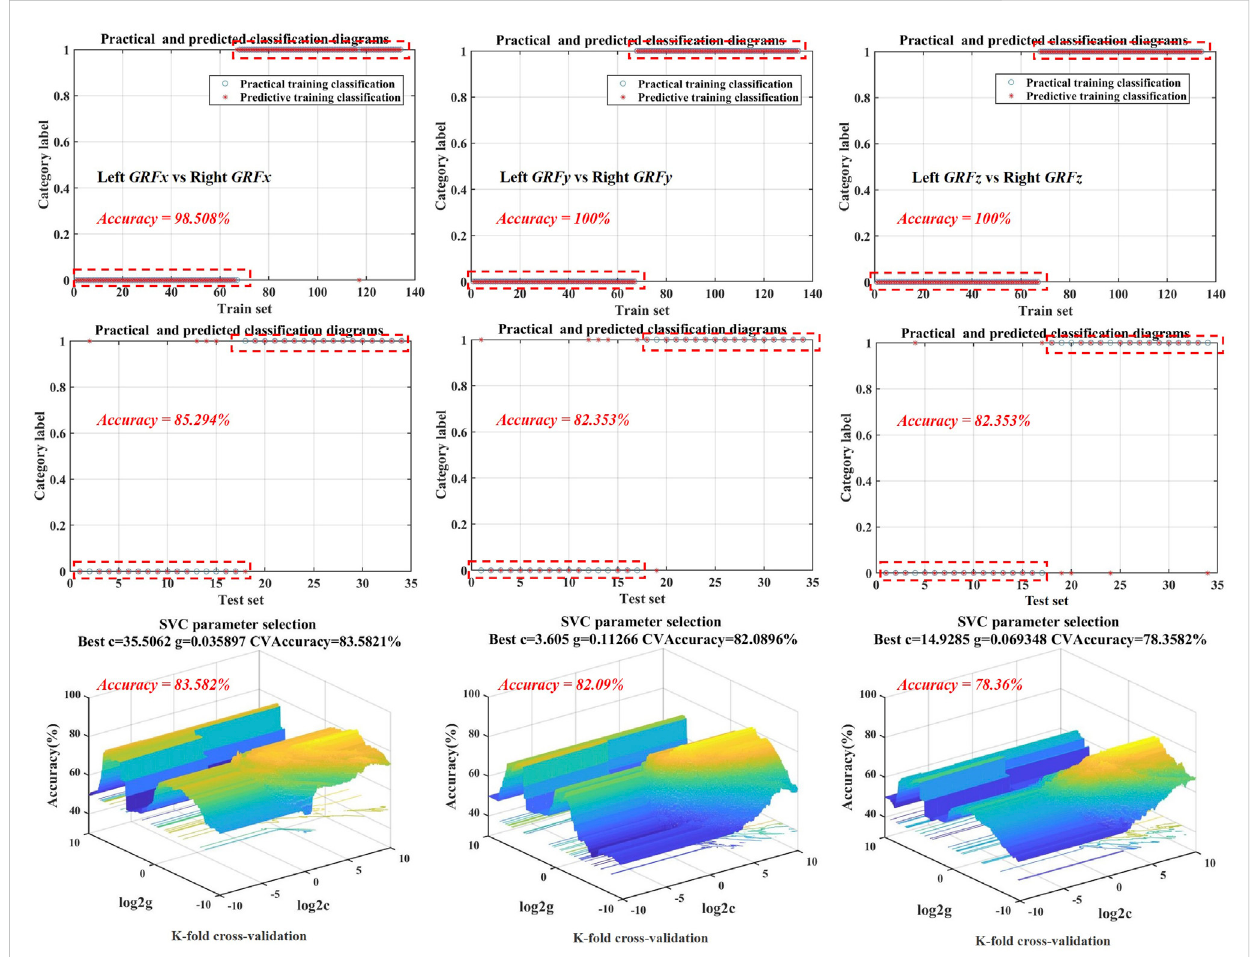
FIGURE 5 The training set, test set, and cross-validation model accuracy visualization are based on optimal kernel function selection for SVM models of GRFx, GRFy, and GRFz. GRFx: medial-lateral direction of GRF, GRFy: anterior-posterior direction of GRF, GRFz: vertical direction of GRF.